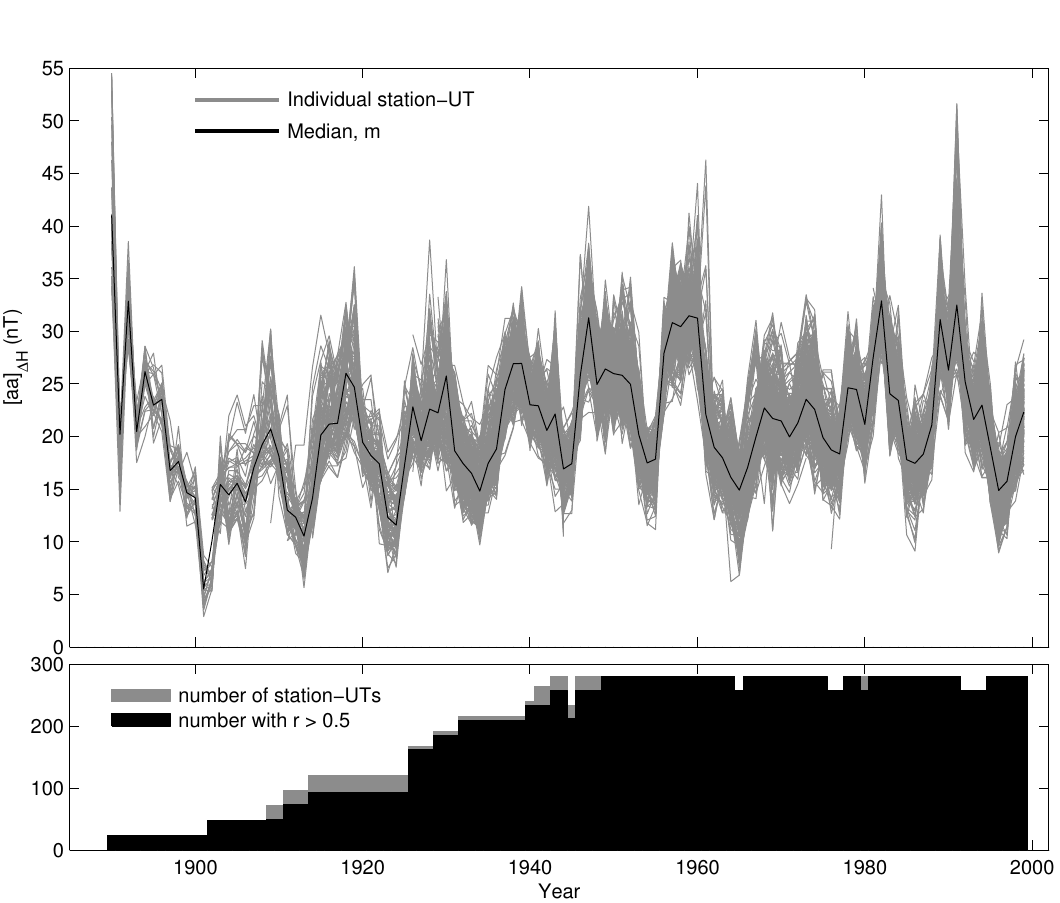
Figure 6: The median index, 𝑚 . For each station at a given UT, the standard deviation of the hourly means of the horizontal component of the geomagnetic field is computed over a full year, 𝜎 𝐻 then correlated with, and linearly regressed against, the annual means of aa shown in Figure 4 to yield 𝜎 ′ = 𝑠 × 𝜎 𝐻 + 𝑐 . These normalisations are needed because both the sensitivity 𝑠 and offset 𝑐 for a station 1yr have been shown to depend on its location and on the UT hour (which, for example, alters the location of the station relative to the midnight-sector auroral oval) (Finch, 2008). Each station-UT is treated as an independent data series. The grey lines show the variations of the 𝜎 ′ values for all station-UTs for which the correlation coefficient exceeds 0.5 and is significant at the 2 𝜎 level. The number of station-UTs meeting this criterion is shown as a function of time by the black histogram in the lower panel. The black line in the upper panel is the median of all the available data for each year and is called the “median index”, 𝑚 . Image reproduced from Lockwood et al.